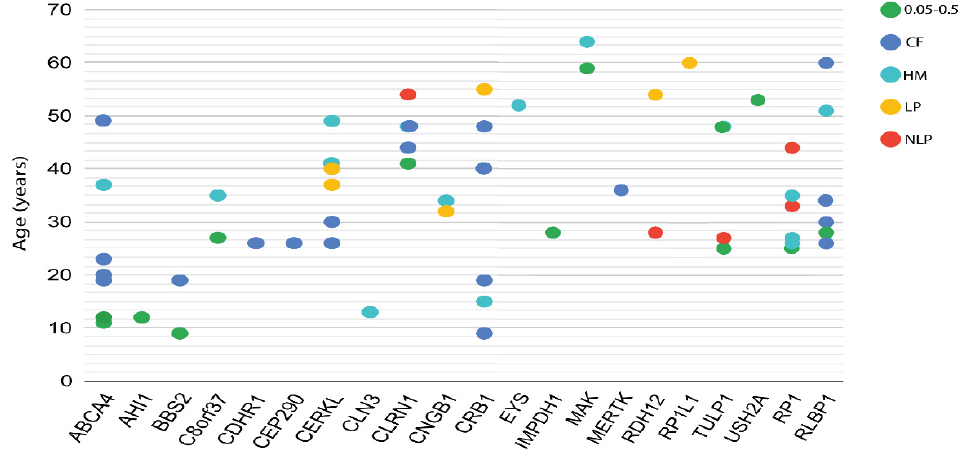
Figure 3. Correlation between visual acuity, age at exam and genes in which potential DCVs were identified. The phenotypic severity of visual acuity is classified into five groups, which are plotted in different colors. CF: counting fingers, HM: hand motion, LP: light perception, NLP: no light perception. Genes are plotted on the X-axis, while the Y-axis represents the patients’ ages at exam.